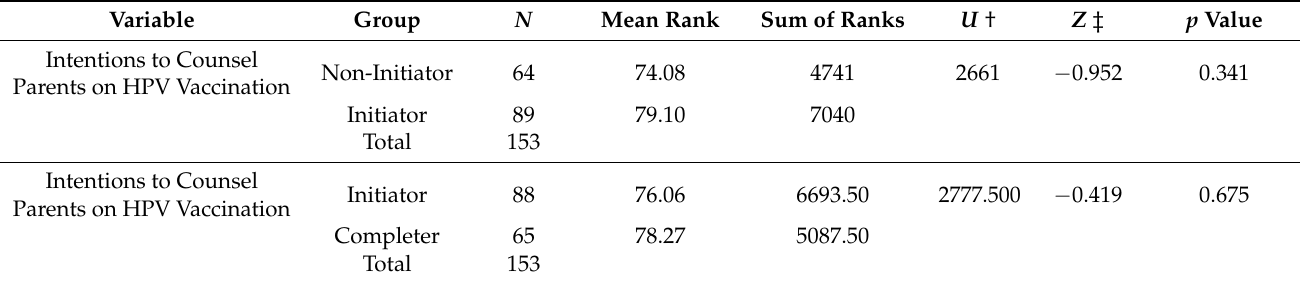
Table 4. Mann–whitney U test comparing non-initiators and